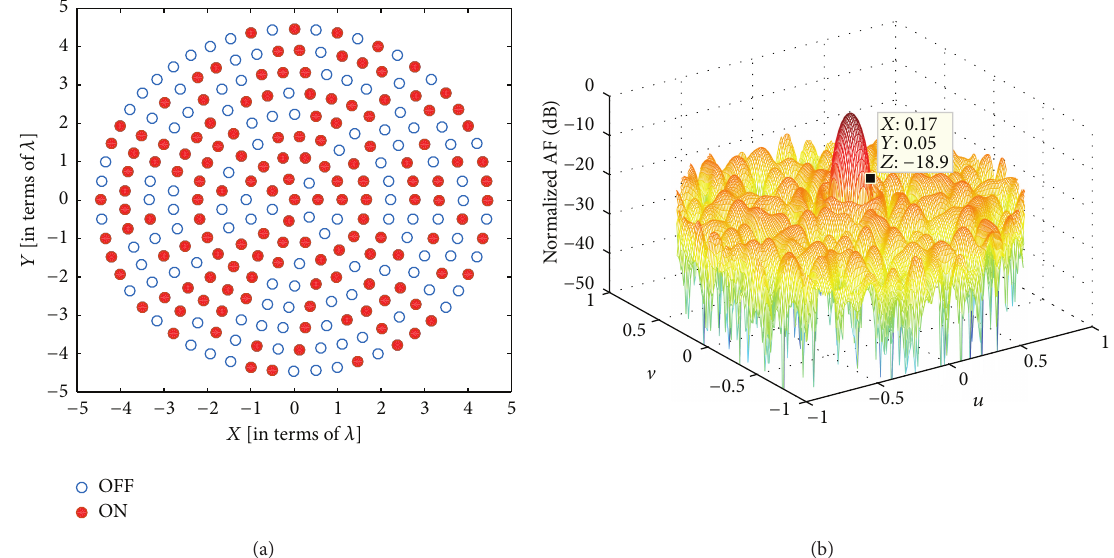
Figure 3: Uniform CCAA optimized by MTLBO for SLL reduction in general space. (a) Configuration of a 141-element uniform array and (b) the related array factor with SLL = − 18.9dB and FNBW = 0.13.